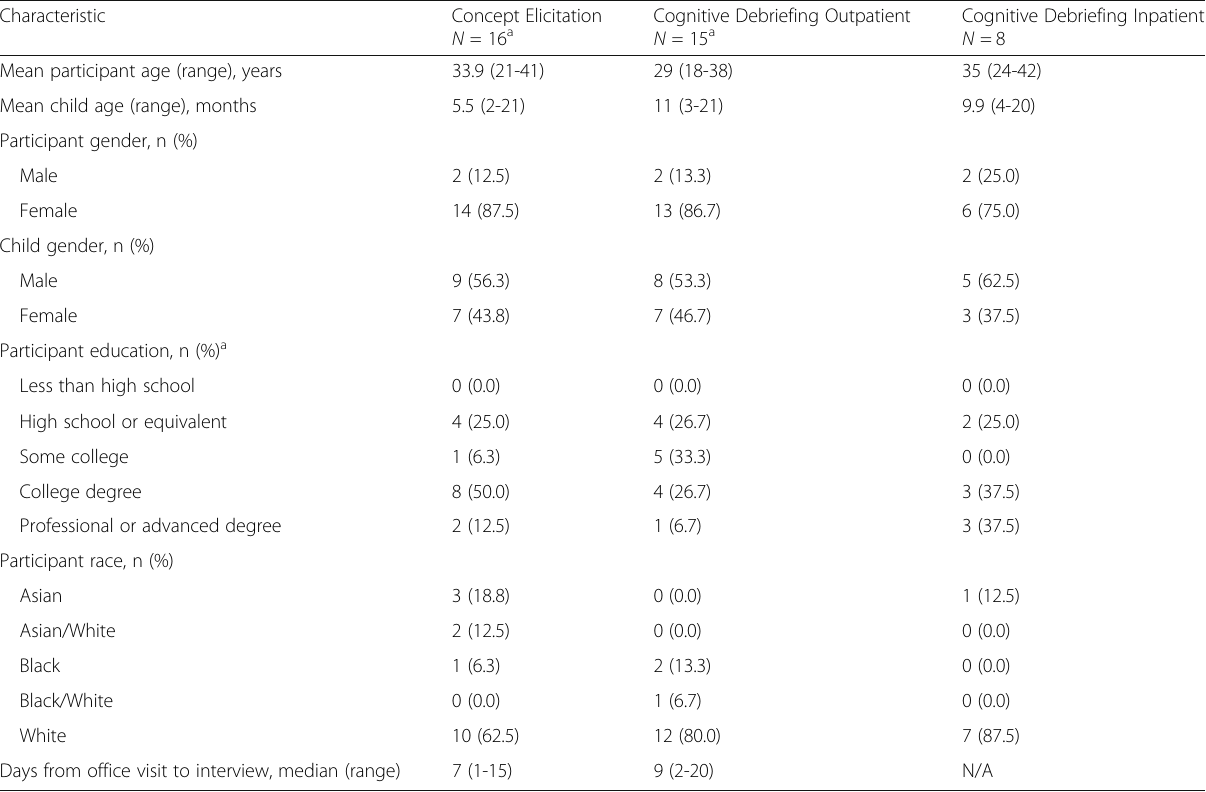
Table 2 Characteristics of Interview